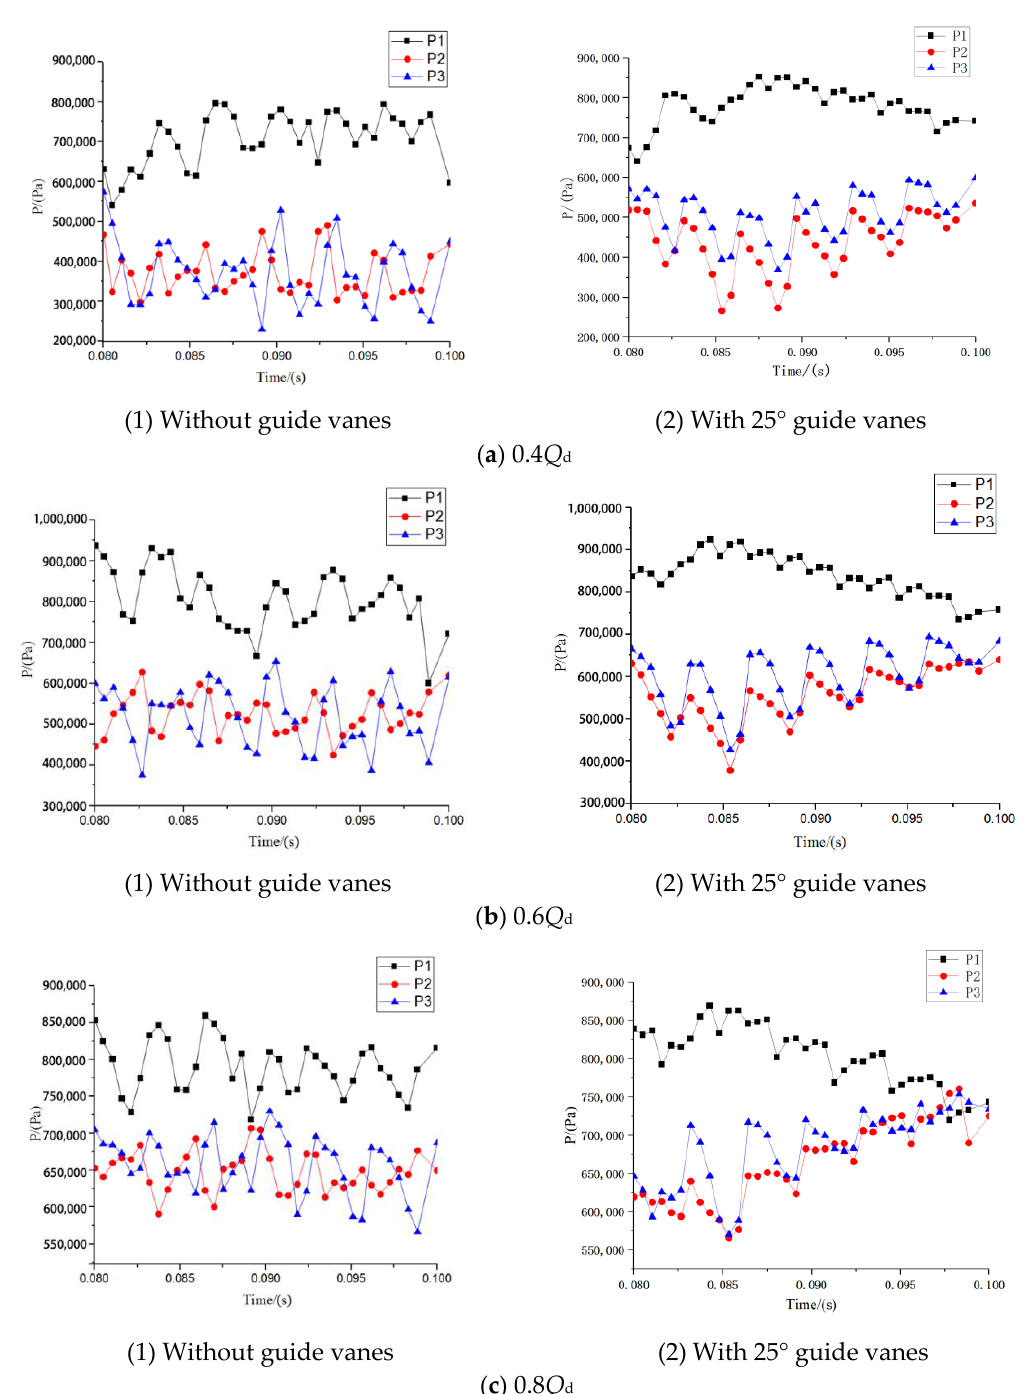
Figure 14. Monitoring point pressure pulsation near the tongue for different flow rates: ( a ) 0.4 Q d , ( b ) 0.6 Q d , ( c ) 0.8 Q d.